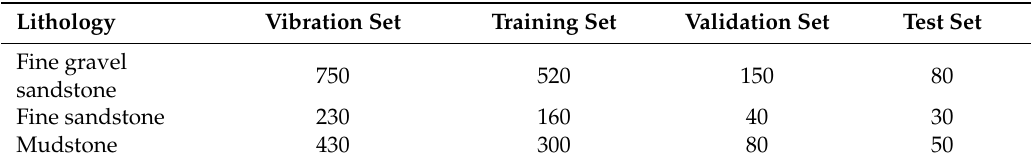
Table 2. Split dataset.